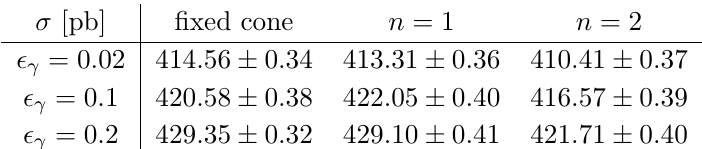
Table 2 . Cross-section at R = 0 . 4 for different photon isolation criteria computed using MCFM [52]. The cross section values correspond to the kinematics and input specified in table 1 with µ f = µ r = 125 GeV . For this scale choice, the direct part of the cross section is σ dir ≈ 308 pb